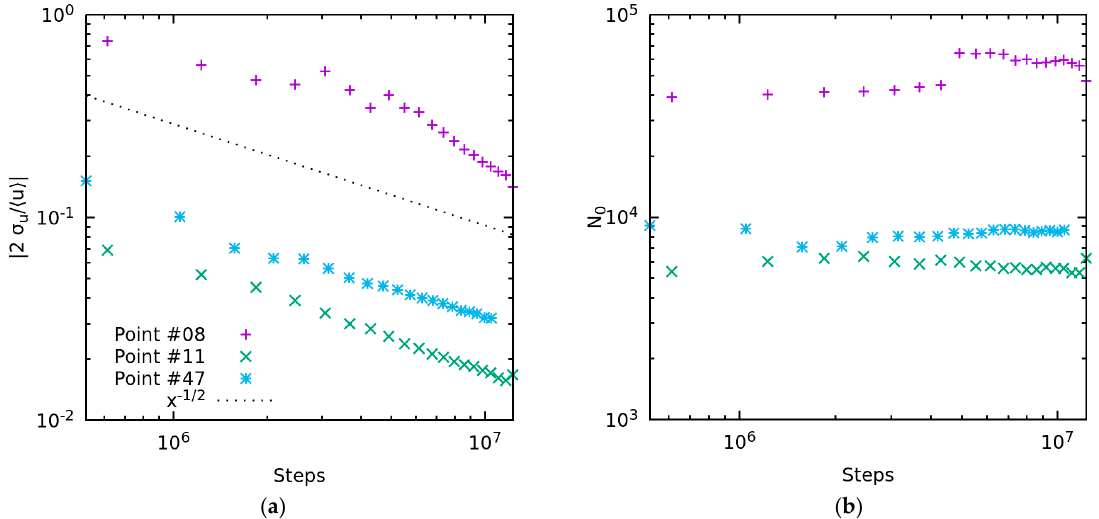
Figure 4. Convergence of relative 2𝜎 uncertainty of average streamwise component in three monitor points ( a ) and convergence of the decorrelation time expressed as number of time steps ( b ).